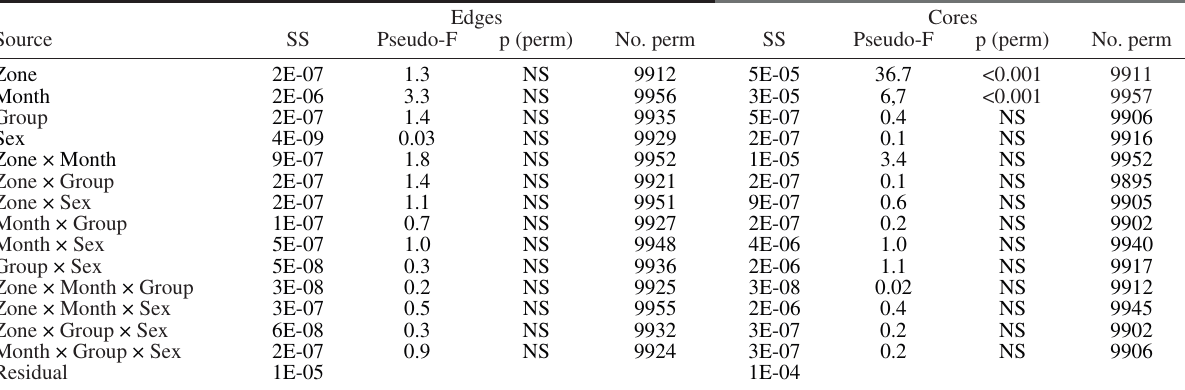
Table 2. – Results of the permutational multivariate analysis of variance based on a Euclidean distance matrix of the standardized concentra- tions of element/calcium ratios for Mg, Al, Mn, Ni, Zn, Sr, Cu, Rb, Pb and Ba in edges and cores of otoliths from Engraulis ringens caught off central Chile and northern Patagonia (obtained using 9999 permutations of residuals under a reduced model). Edges